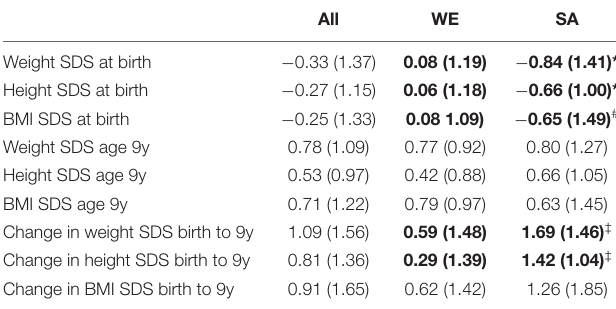
TABLE 1 | Anthropometric data from birth to the median age of 9.1 years.